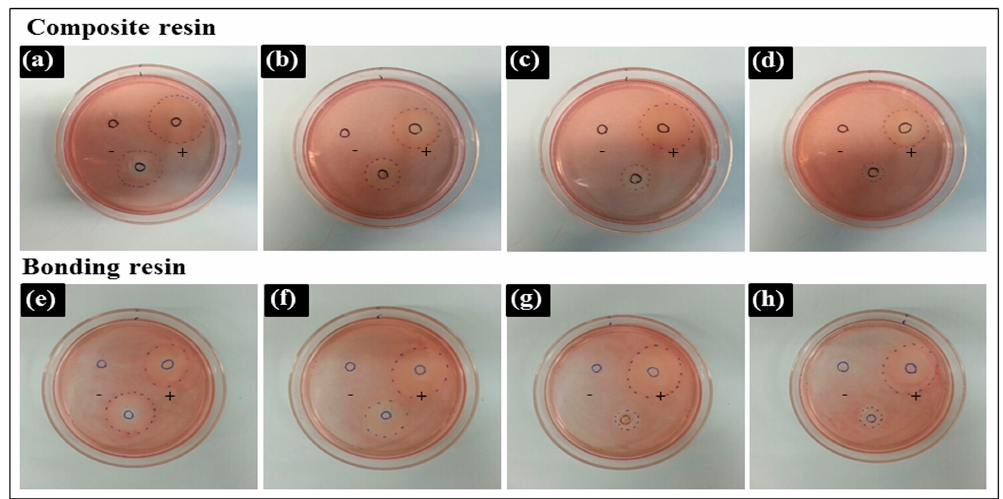
Figure 2. Decolorization zones of experimental materials in the agar diffusion test. The empty Teflon mold (negative control), the latex sheet from the latex glove (positive control), and experimental samples of ( a ) uncured composite resin (CU); ( b ) directly cured composite resin (CD); ( c ) post-cured composite resin (CP); ( d ) composite resin after removing the unreacted layer (CR); ( e ) uncured bonding resin (BU); ( f ) directly cured bonding resin (BD); ( g ) post-cured bonding resin (BP); ( h ) bonding resin after removing the unreacted layer (BR) were located in predetermined positions. Representative images are shown after experiments were performed in triplicate. Table 4. Results of the agar diffusion test.